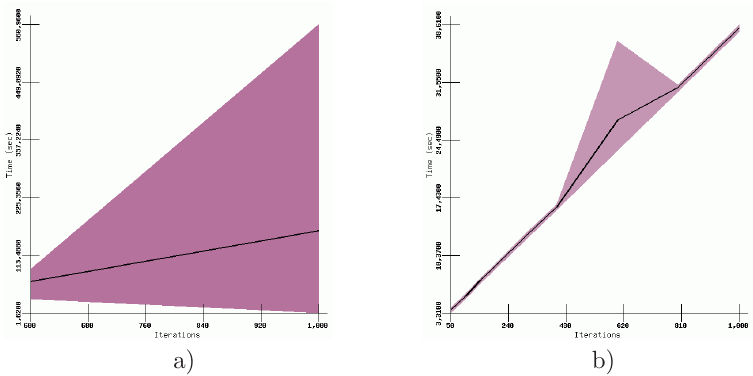
Figure 9. Dependence of the computing time on the iteration number on a basis of the fixed experiments (using Relative MDS, PCA initialization method, 1000 iterations): (a) Ellipsoidal, (b) Sphere data